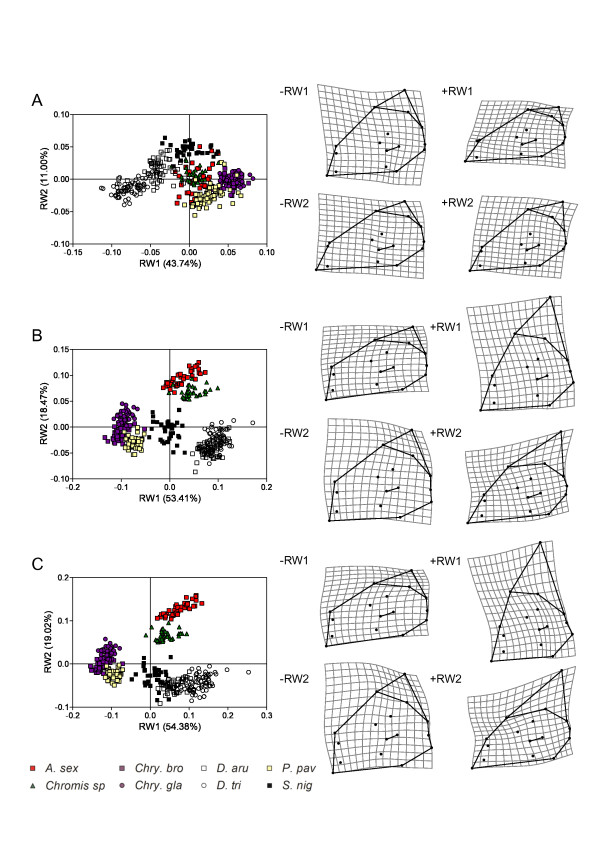
Ontogenetic dynamics of the patterns of neurocranium shape disparity. Relative warps analyses of the neurocranium shapes at the three ontogenetic stages. A, shapes at the settlement stage. B, shapes at an intermediate size of 60 mm SL. C, shapes at the maximum adult body size. TPS deformation grids indicate shape variation represented by RW1 and RW2 (minimal (-RW) and maximal (+RW) values).